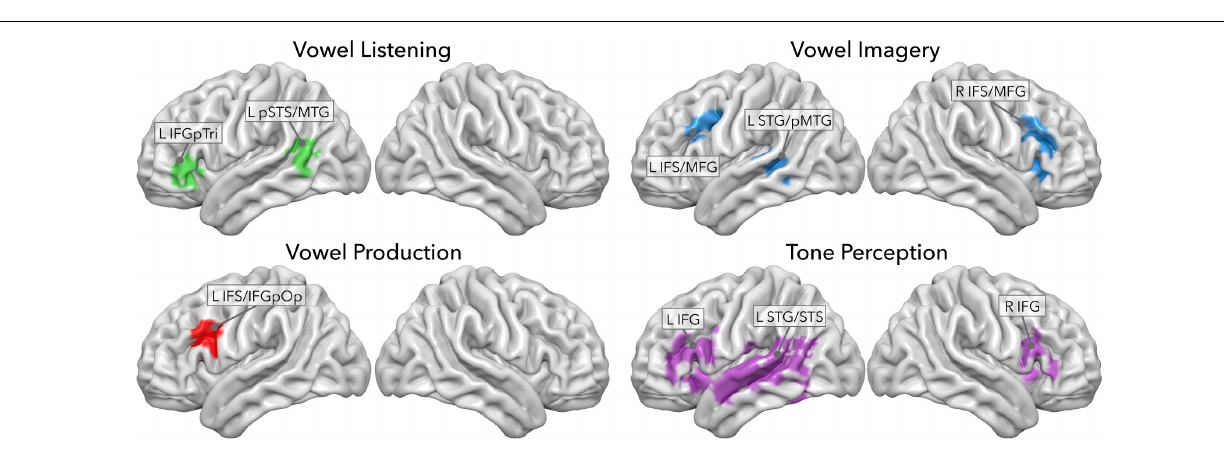
FIGURE 2 | Searchlight classifier results from Rampinini et al. (2017). Each panel shows regions where model-free decoding was successful in each